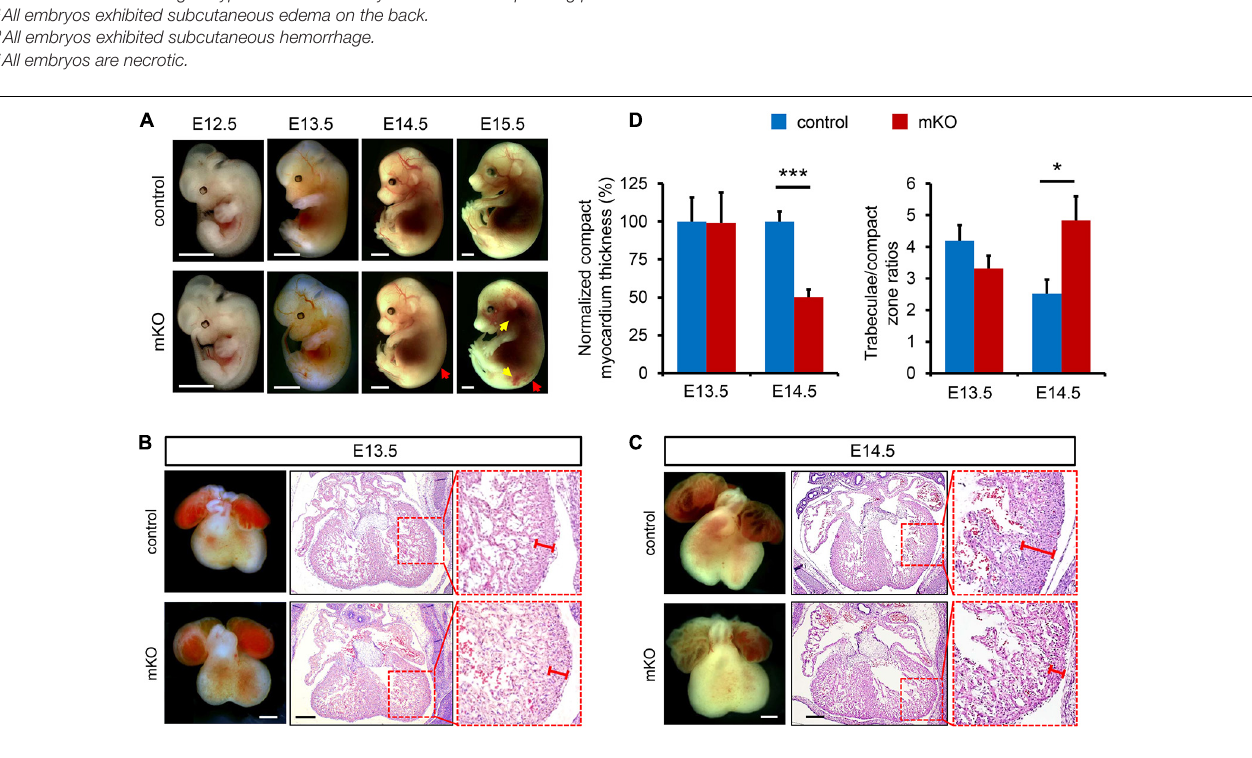
FIGURE 1 | Deletion of SETD2 leads to abnormal cardiac development. (A) Representative morphology of control and Mesp1-Cre + Setd2 f / f (mKO) embryos at E12.5, E13.5, E14.5, and E15.5. Please note that mKO embryos show subcutaneous edema (red arrow) and hemorrhage (yellow arrow) after E14.5. Scale bar, 2 mm. (B,C) Morphological and histological analyses of control and mKO hearts at E13.5 (B) and E14.5 (C) . Boxed areas are magnified on the right. The ventricular compact zone is indicated by red lines. Scale bar, 400 µ m. (D) Quantitative analysis of the thickness of the myocardium compact zone and the degree of hypertrabeculation at E13.5 ( n = 5 for each group) and E14.5 ( n = 4 for each group). The measurements were acquired in three evenly spaced regions along the perimeters of left ventricles. All data represent mean ± SEM. Significance was determined by two-tailed, unpaired Student’s t test. * p < 0.05, *** p < 0.001